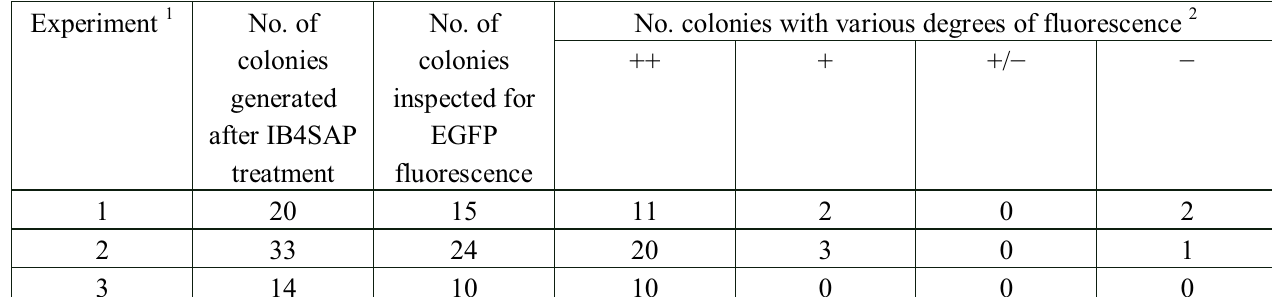
Table 1. Summary of Experiment